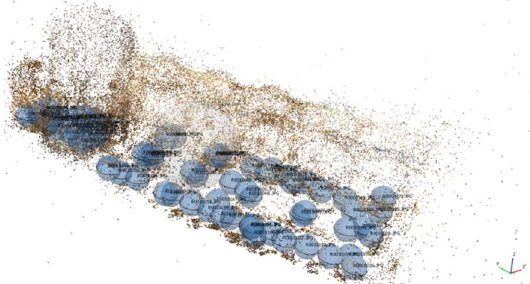
Figure 14. The aligned spherical